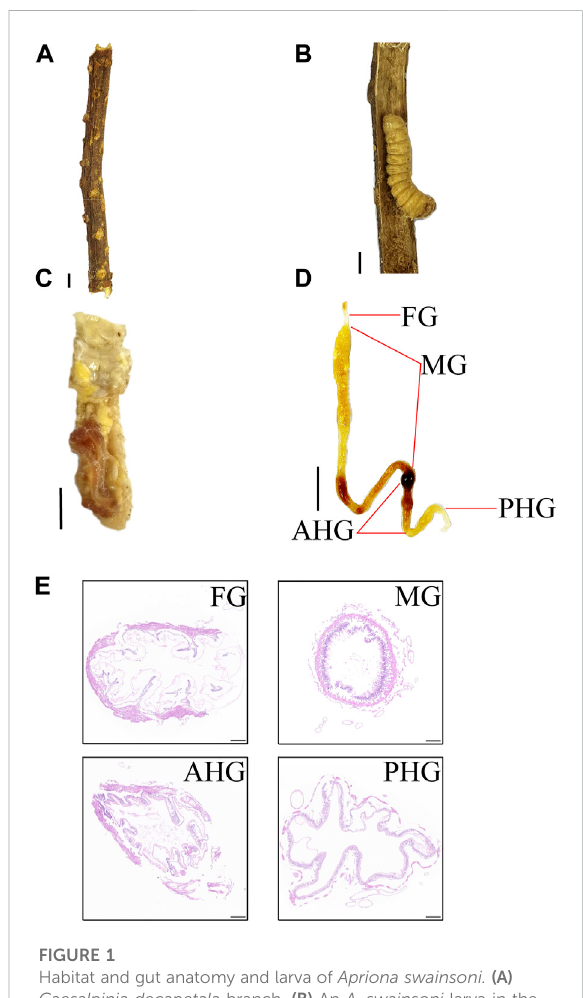
FIGURE 1 Habitat and gut anatomy and larva of Apriona swainsoni. (A) Caesalpinia decapetala branch. (B) An A. swainsoni larva in the branch of Caesalpinia decapetala . (C) Insect body anatomy of A. swainsoni larva. (D) Depiction of the digestive gut and its four main regions when fully removed and extended. FG, foregut; MG, midgut; AHG, anterior hindgut; PHG, posterior hindgut. (E) HE staining of four gut segments. Scale bar, 1 cm (ABCD), 100 µm (E)